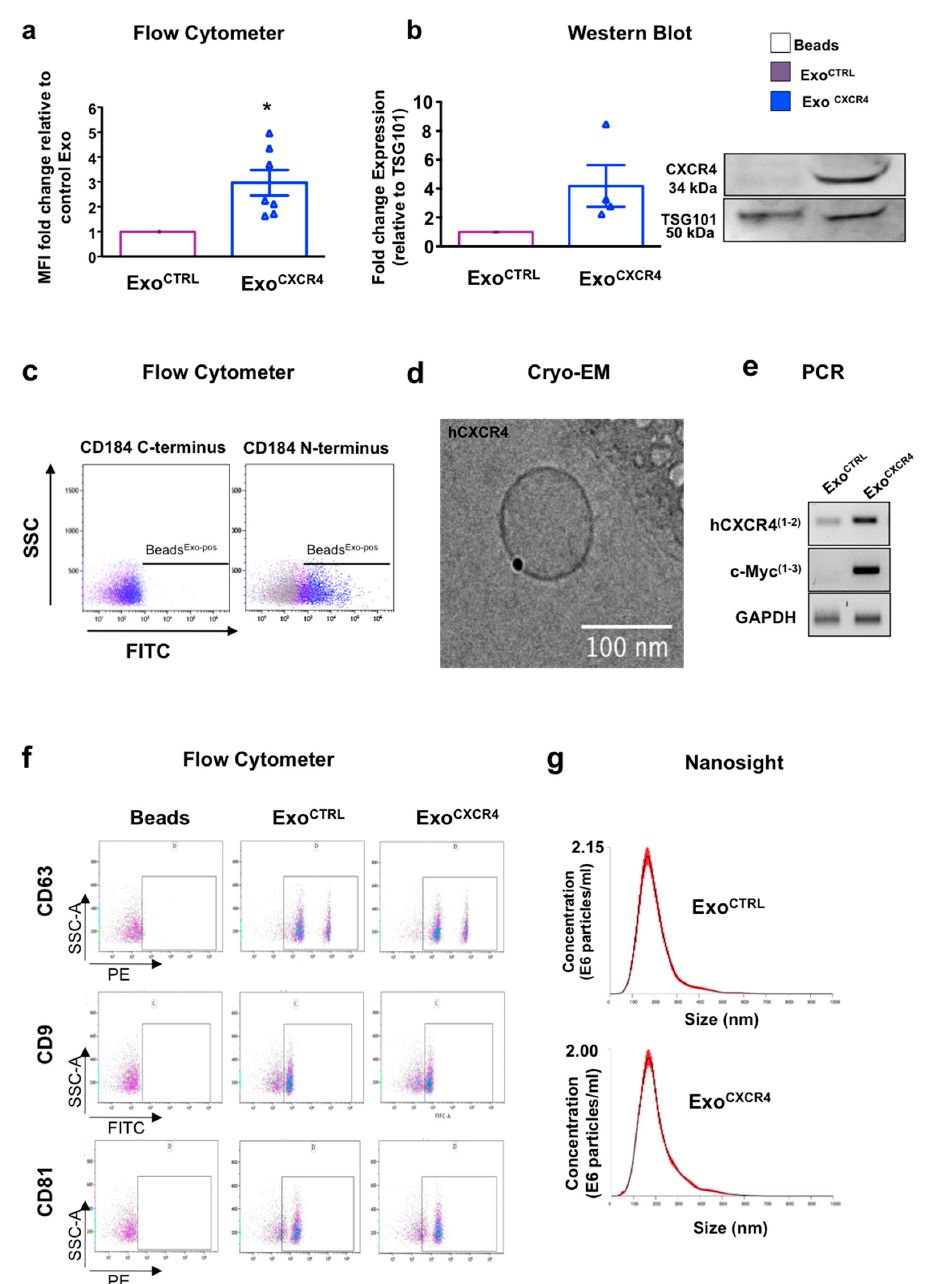
Figure 2. CXCR4 expression. ( a ) Quantitative data flow cytometer analyses for relative